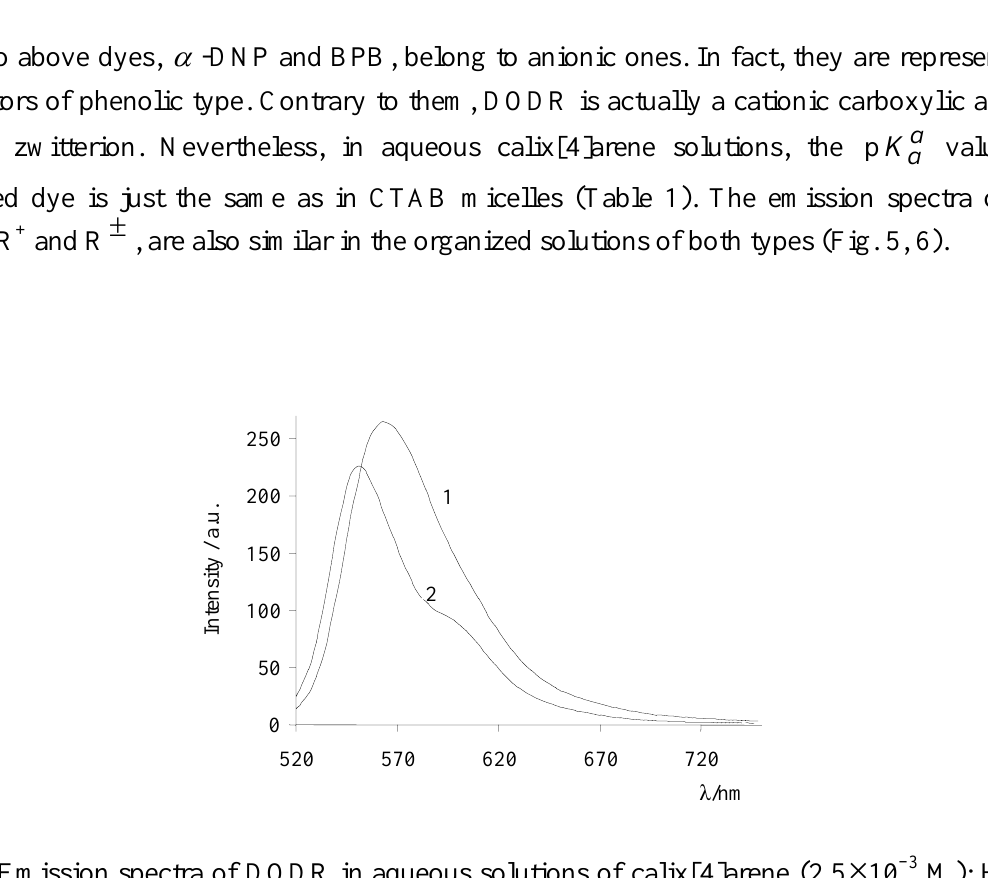
Figure 5. Emission spectra of DODR in aqueous solutions of calix[4]arene (2.5 × 10 –3 M): HR + , pH = ± , pH = 6 1.2 (1) and R